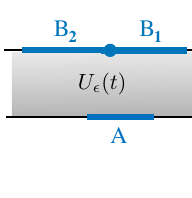
are the spatially 1-dimensional H 1 ; 2 to . (a) Bi-partite case, (b) Tri-partite H input H output